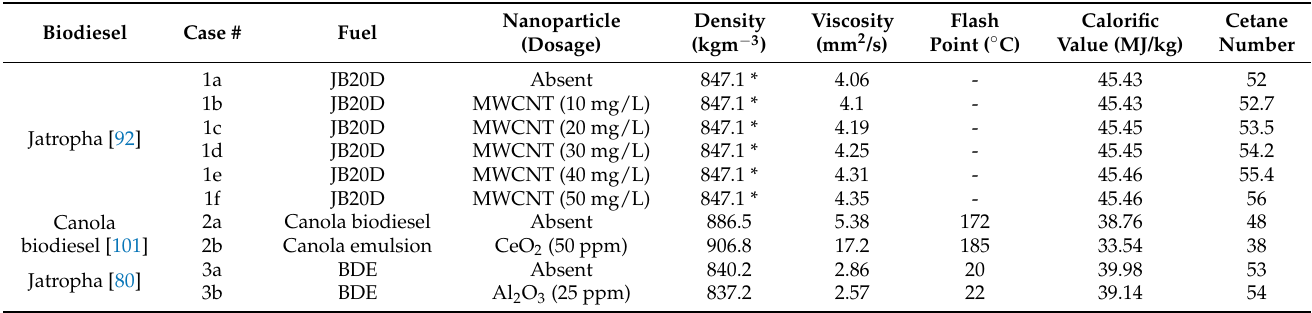
Table 3. Summary of nanoparticles’ effect on fuel properties of biodiesel-based